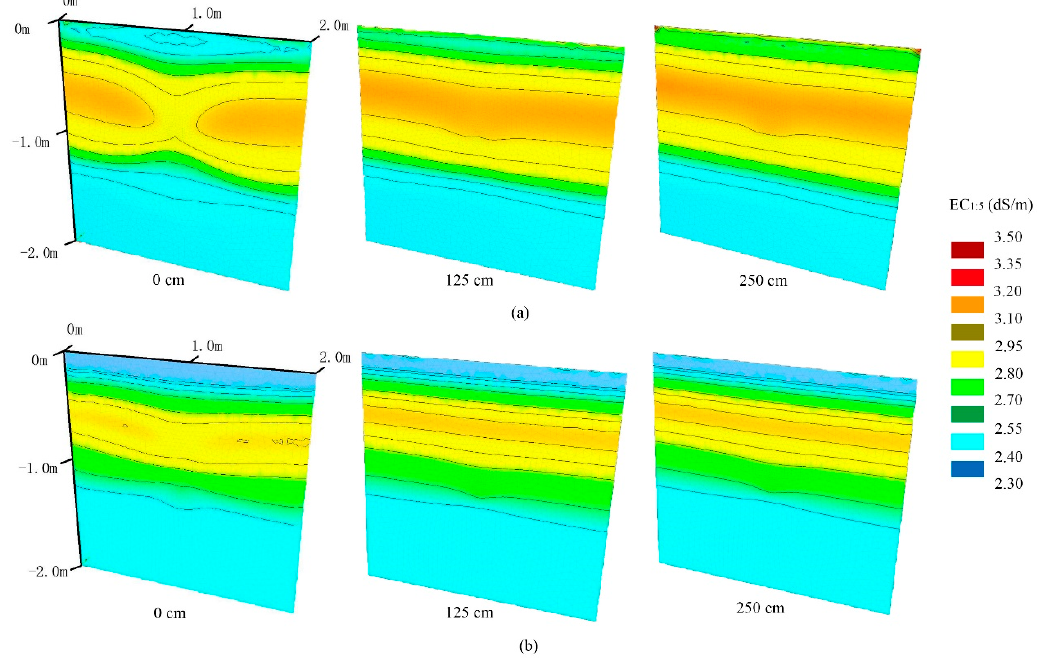
Figure 6. Simulated soil salt distribution in di ff erent soil vertical profiles (0, 125, and 250 cm away from the outlet) for treatment D1W1 ( a ) and D2W1 ( b ) at the end of the experiment (30th day). The color legend on the right side indicates soil salinity (EC 1:5 ) in the soil profile, and the di ff erent color lump represents a certain range of soil salinity (e.g., the darker blue lump at the bottom of the color legend means the soil salinity is in the range of 2.30–2.40 dS m − 1 ).